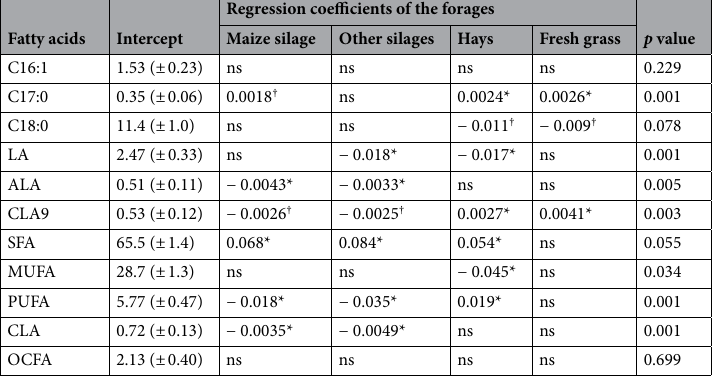
Table 5. Multiple linear regression equations of the most discriminant milk fatty acids (FA) and their derived chemical classes based on the dietary forage sources (% DM). Each equation (data of FA are as g/100 g of total detected fatty acids) is presented in the following format: intercept of the model (± standard error) and regression coefficient of the forages, when significant (* p < 0.05; † p < 0.10; ns = p > 0.10). The p value refers to the significance of the regression model. LA = linoleic acid, C18:2 c -9, c -12; ALA = alpha linolenic acid, C18:3 c -9, c -12, c -15; CLA9 = C18:2 c -9, t -11. For the other fatty acids abbreviations see Table 3.